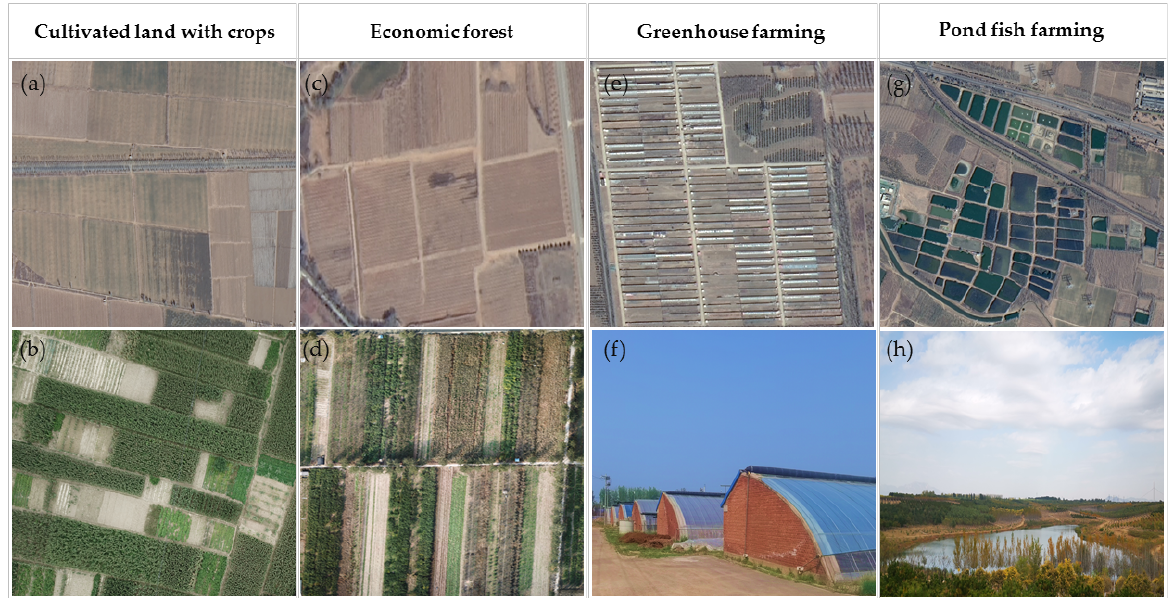
Figure 1. Non-grain production in cultivated land. ( a , b ) are cultivated land with crops and vegeta- bles, ( c , d ) are economic forests, ( e , f ) are greenhouse farms, and ( g , h ) are pond fish farms. Pond fish farms and greenhouse farms are easy to distinguish, whereas economic forests are easily confused with cultivated cropland.